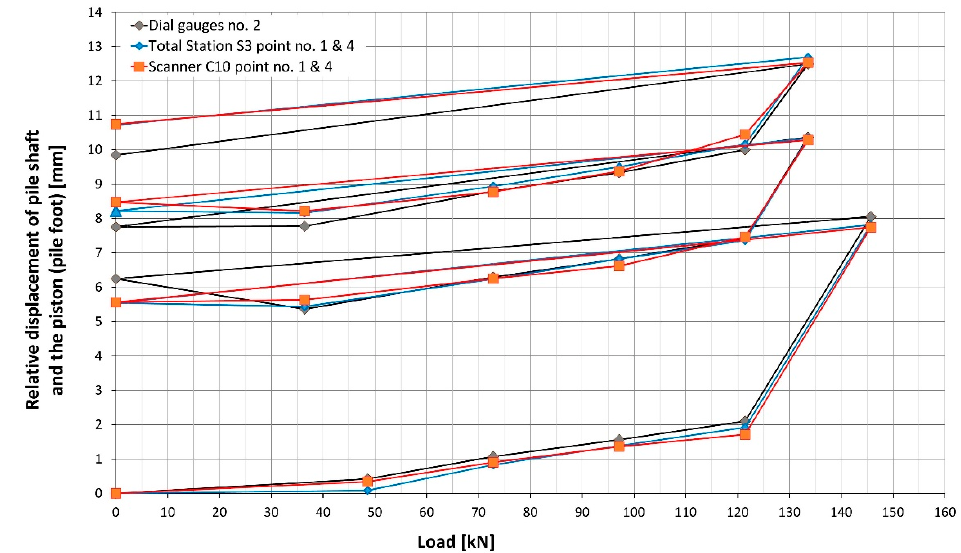
Figure 14. The relative displacement of the pile shaft and the piston (pile foot) calculated for a pair of checkpoints no. 1 and no. 4.